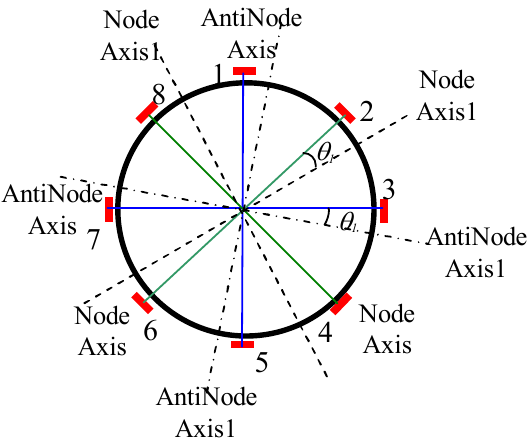
Figure 4. The rotation of vibration mode